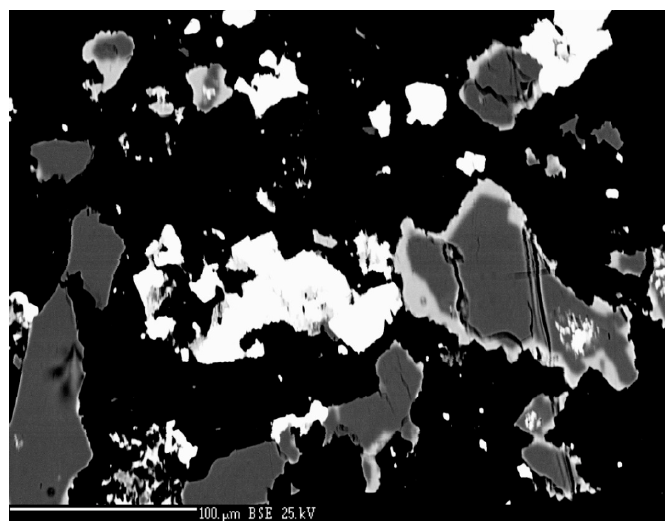
Figure 59. Zn-tetrahedrite aggregates (middle grey) overgrowing anhedral chalcocite (dark grey) in